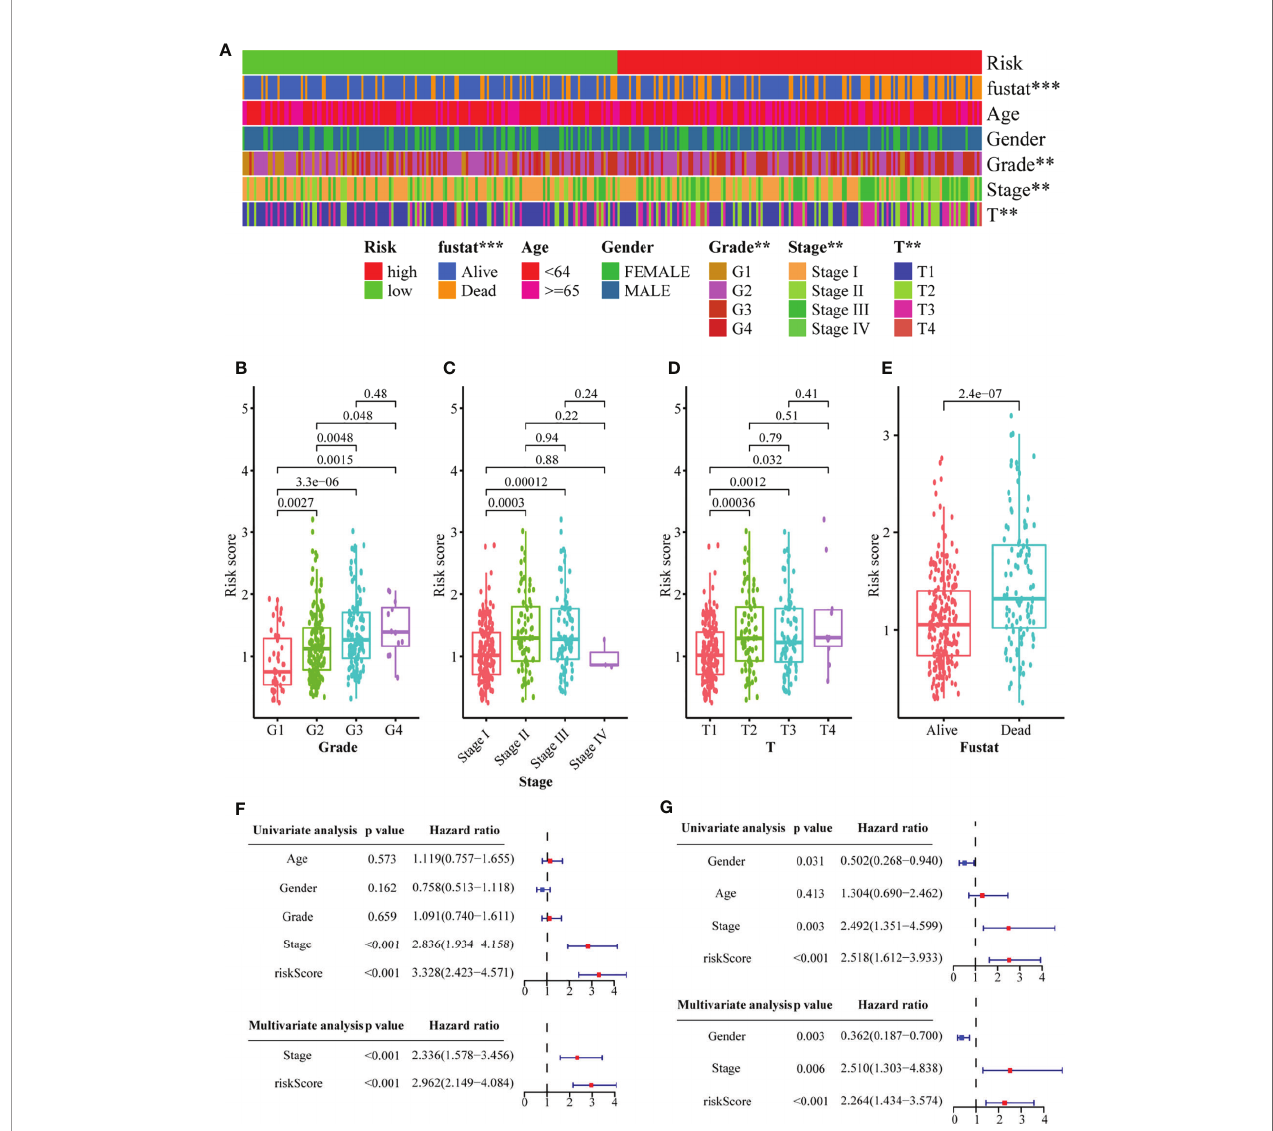
FIGURE 5 | Associations between the signature risk scores and clinicopathological characteristics. (A) Heatmap of the clinicopathological characteristics and the risk score; (B – E) The risk score in different groups divided by clinical characteristics. Univariate Cox regression analyses and multivariate Cox regression analyses regarding OS in the TCGA (F) and the ICGC (G) set. ** P <0.01; *** P